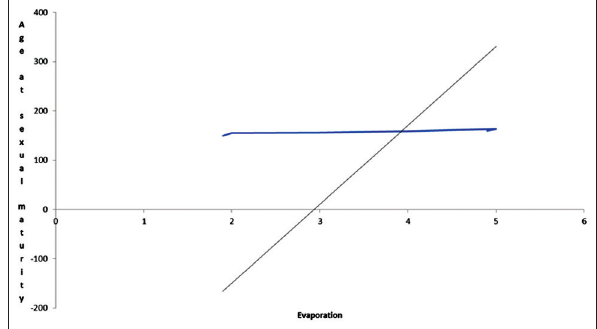
Figure-1: Effect of evaporation of moisture on age at sexual